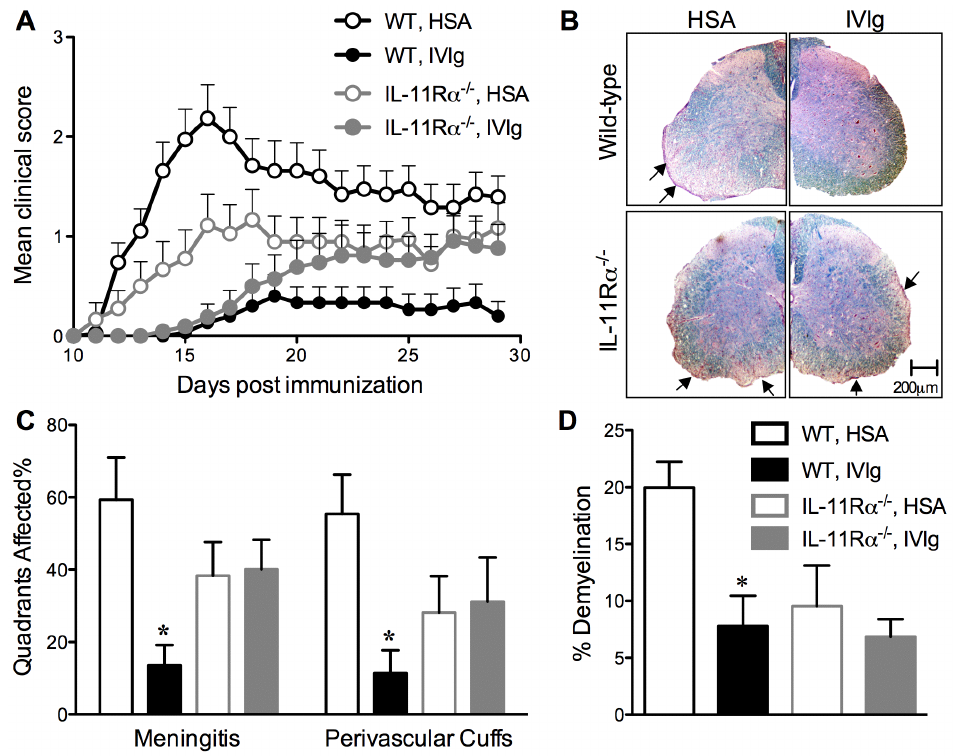
Figure 3. IL-11R a 2 / 2 mice are more resistant to the protective effects of IVIg treatment during EAE. EAE was induced in C57BL/6J IL- 11R a + / + littermates (WT) or IL-11R a 2 / 2 mice that were administered IVIg or HSA (1 g/kg) daily beginning on the day of EAE induction. Mice were followed for clinical signs and a histological analysis of inflammation and demyelination was conducted at the end-point of the experiment. A , shows the mean + SEM clinical scores of mice over a time-course of EAE. The graph shows combined data from three consecutive EAE studies that each contained (N=5–10 mice/group). B , shows representative spinal cord sections from control- or IVIg-treated IL-11R a 2 / 2 or WT mice stained with haematoxylin and eosin and luxol fast blue. C , shows the percent quadrants of spinal cords (N=10 sections/mouse) that were positive for meningitis or perivascular cuffs in EAE mice. D , shows the percent demyelination in these spinal cord sections. Values in C&D are means + SEM of N=4–6 mice per group for one representative experiment. *represents a significant difference (*p , 0.05) from the HSA-treated, genotype-matched counterpart as determined by one-way ANOVA and a Tukey post-hoc test.